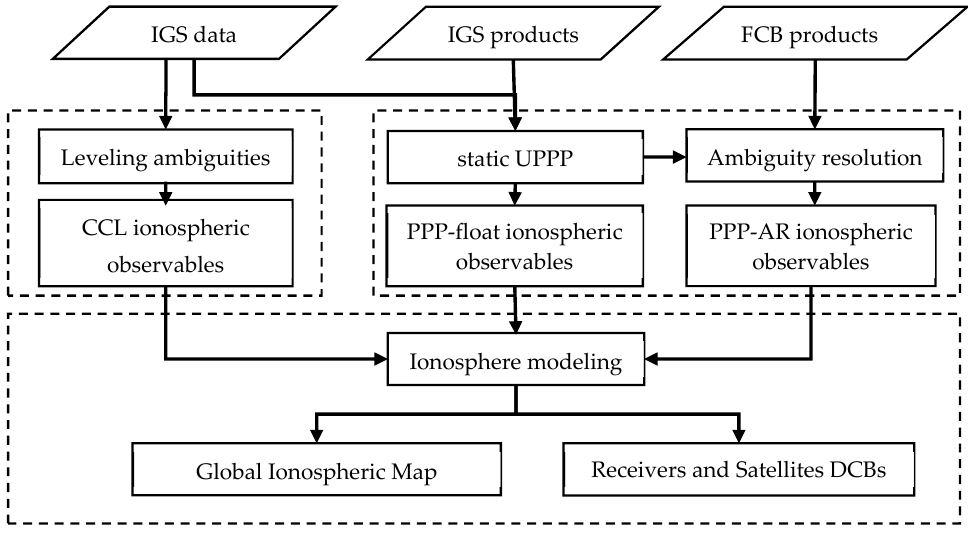
Figure 2. Data processing flowchart of the CCL, PPP-float, and PPP-AR methods.